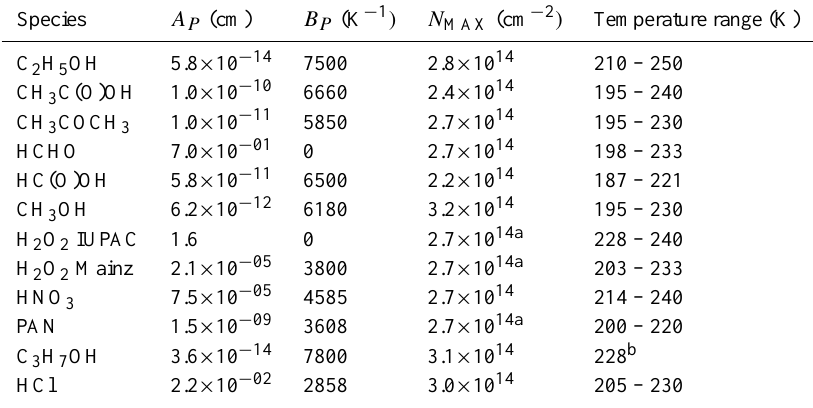
Table 1. Parameters A P and B P used to compute the partition coefficient. K linC , maximum number of molecules N MAX adsorbed on the ice surface and temperature range avaibility for the 11 species taken into account in the present